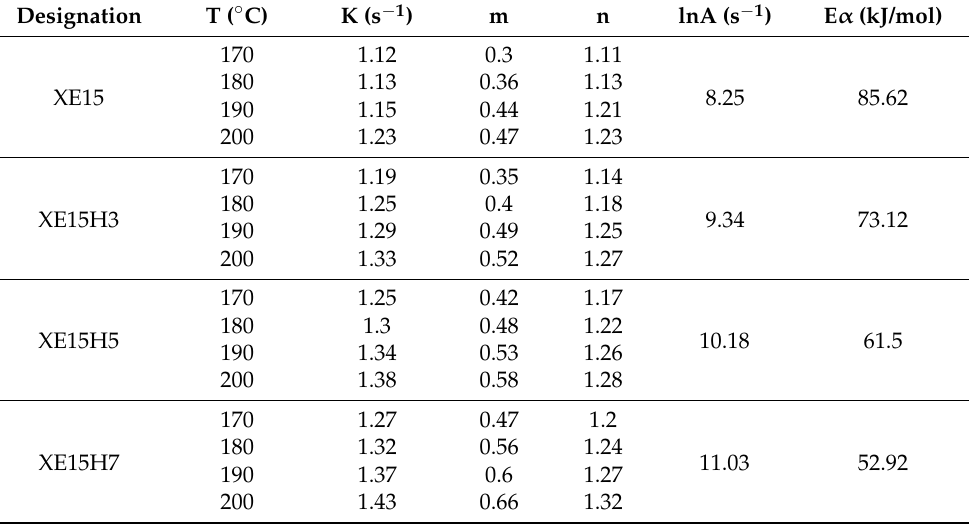
Table 4. Vulcanization kinetic parameters for various XNBR/epoxy/XHNT nanocomposites calcu- lated through using the autocatalytic approach.